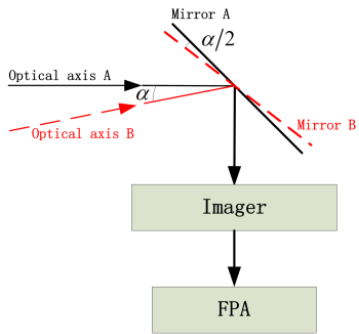
Figure 1. A schematic diagram of utilizing the plane mirror to achieve the line of sight stability.